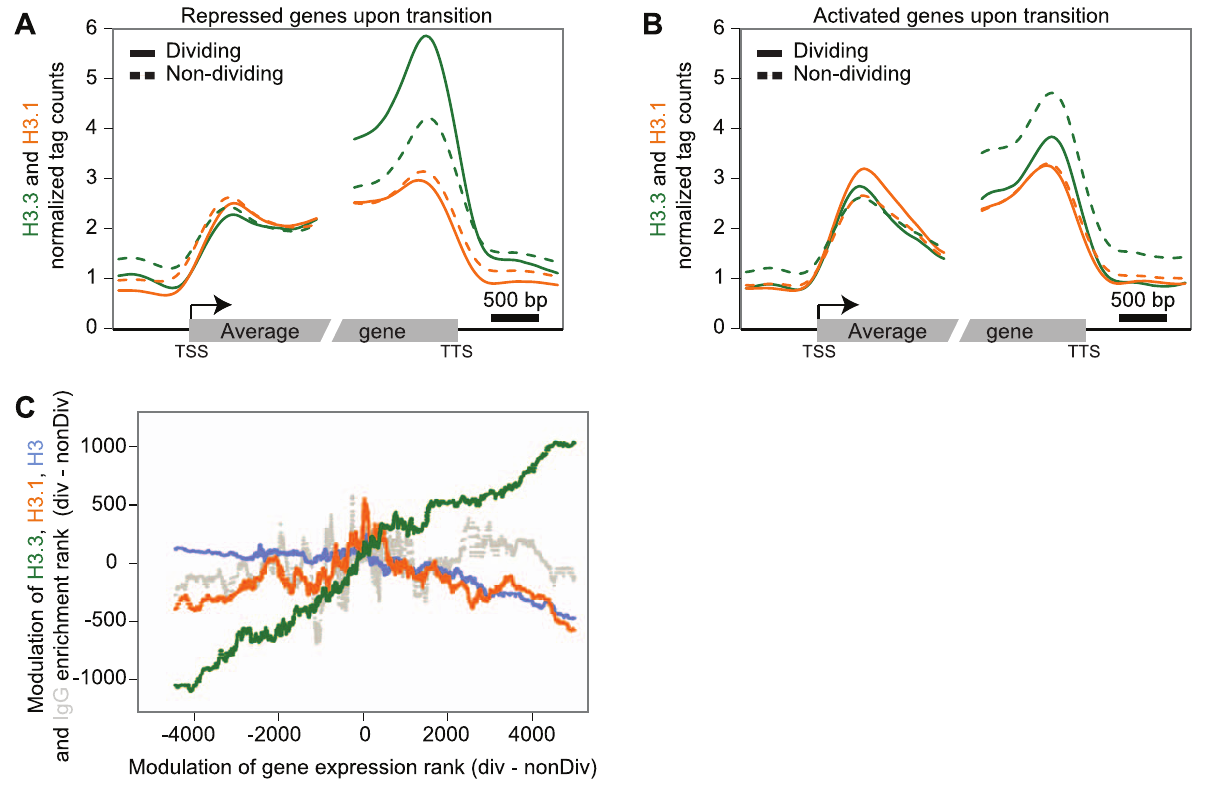
Figure 3. Dynamics of H3.3 and H3.1 enrichment during development. (A–B) Average profile of H3.3 (green) and H3.1 (orange) enrichment over genes that are five fold up-regulated in dividing tissue (plain line) compared to non-dividing tissue (dashed line) (194 genes) (A) and vice versa (88 genes) (B). The average H3.3 enrichment varies during development and follows expression changes (A–B). In contrast, the average H3.1 enrichment does not vary significantly during the developmental transition (A–B). (C) Scatterplots of the modulation of H3.3 (green), H3.1 (orange), H3 (blue) and IgG (dashed grey) enrichment rank versus gene expression rank in dividing compared to non-dividing tissue. A sliding window of 500 genes was applied on both the gene expression difference and the differential enrichment. Only the modulation of H3.3 shows a positive correlation with changes of levels of expression.